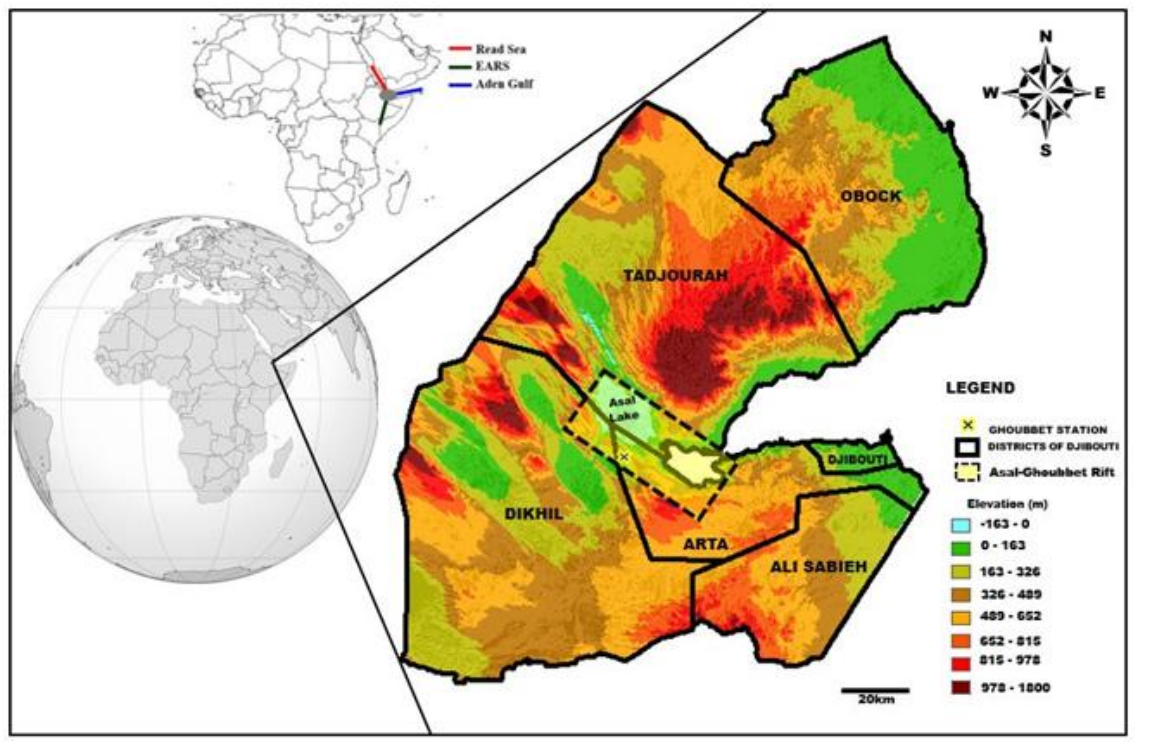
Figure 1. Locations of the wind measurement towers with topographical elevation (The dashed lines show the Asal-Ghoubbet Rift).